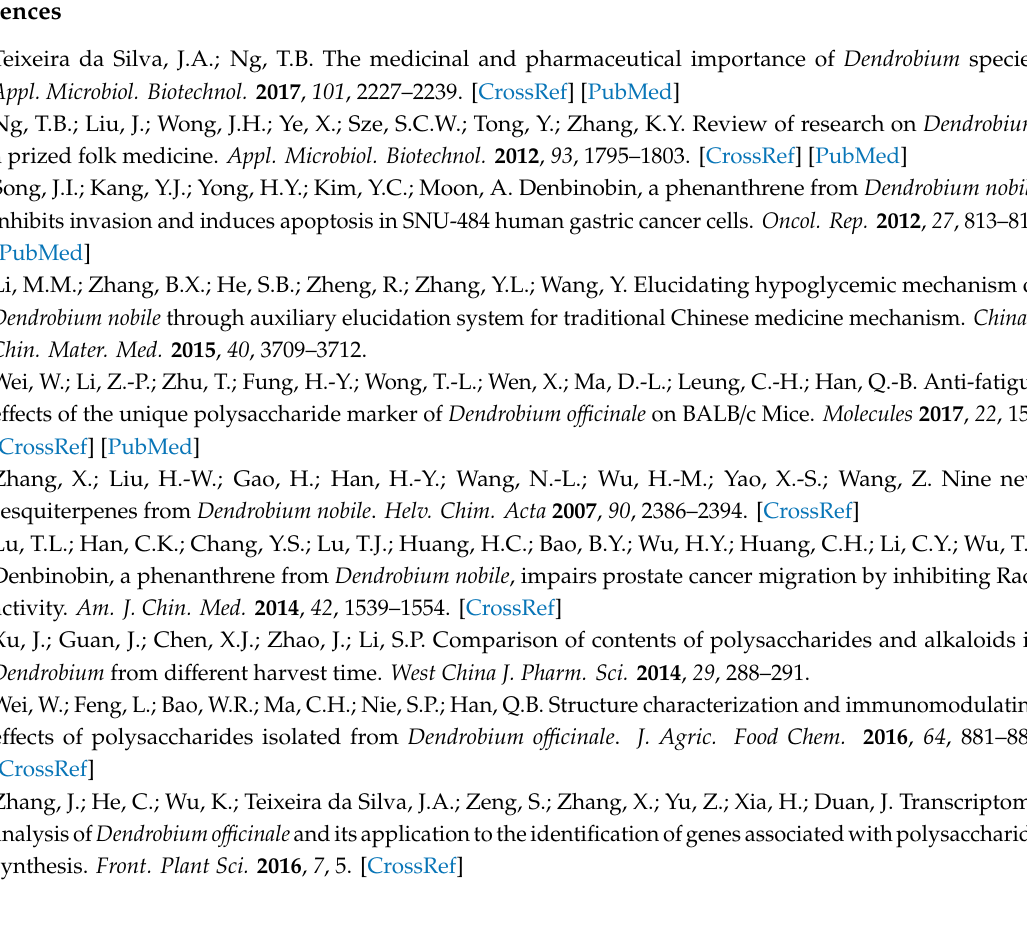
Table S1. List of the metabolites detected in the leaf and stem samples from Dendrobium o ffi cinale and their ion abundance. Metabolites were detected in triplicate samples. Mix represents the mixture of sample extracts, Table S2. List of the di ff erentially accumulated metabolites between leaf and stem samples in Dendrobium o ffi cinale . Author Contributions: H.C., Y.J., and H.L. designed the research. H.C., Y.J., S.L., L.L., M.T. and W.Y. performed the research. H.C., Y.J., S.L., L.L., M.T. and W.Y. conducted data analysis. H.C., Y.J. and H.L. drafted the